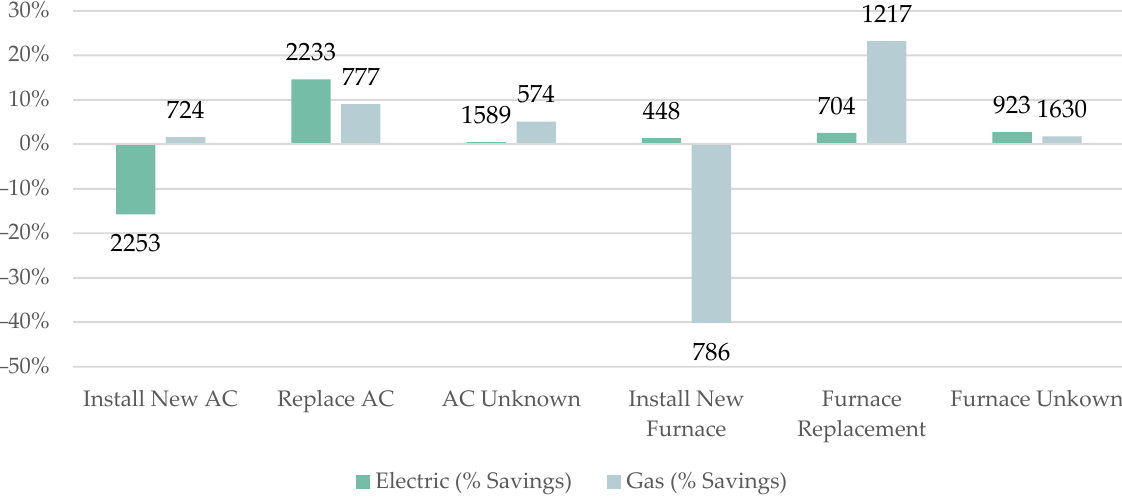
Figure 7. Distribution of percent household gas savings from HVAC-only projects. Note: Numbers above or below each bar show the sample of households inferred to be in that category. Sample sizes for the “other fuel”—gas in the case of the cooling classifications and electricity in the case of the heating classifications—are smaller because some “other fuel” meters failed one of our checks or were missing data altogether.